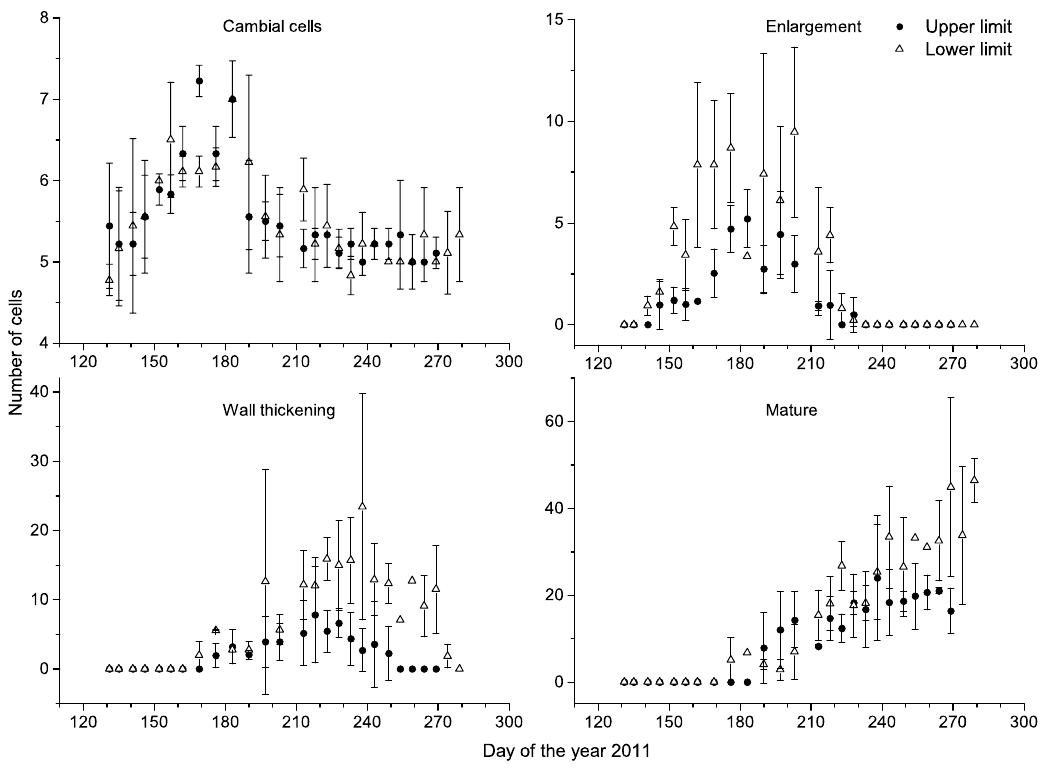
Figure 5. Numbers of cells in the cambial zone, radial enlargement, wall thickening, and maturephase at the upper and lower distribution limits in the year of 2011. Error bars represent standard